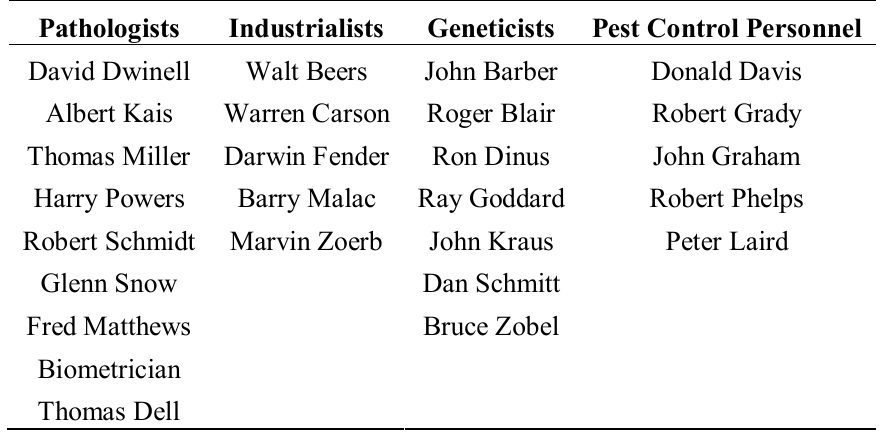
Table 1. Personnel for the proposed Southern Pine Rust Resistance Testing